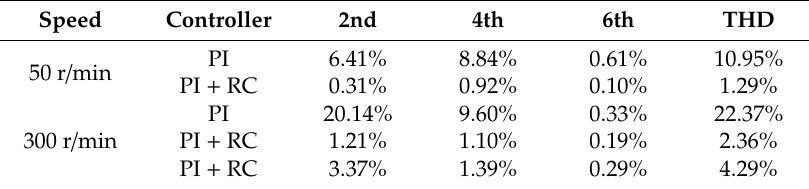
Figure 20. The experimental platform of five-phase PMSM.